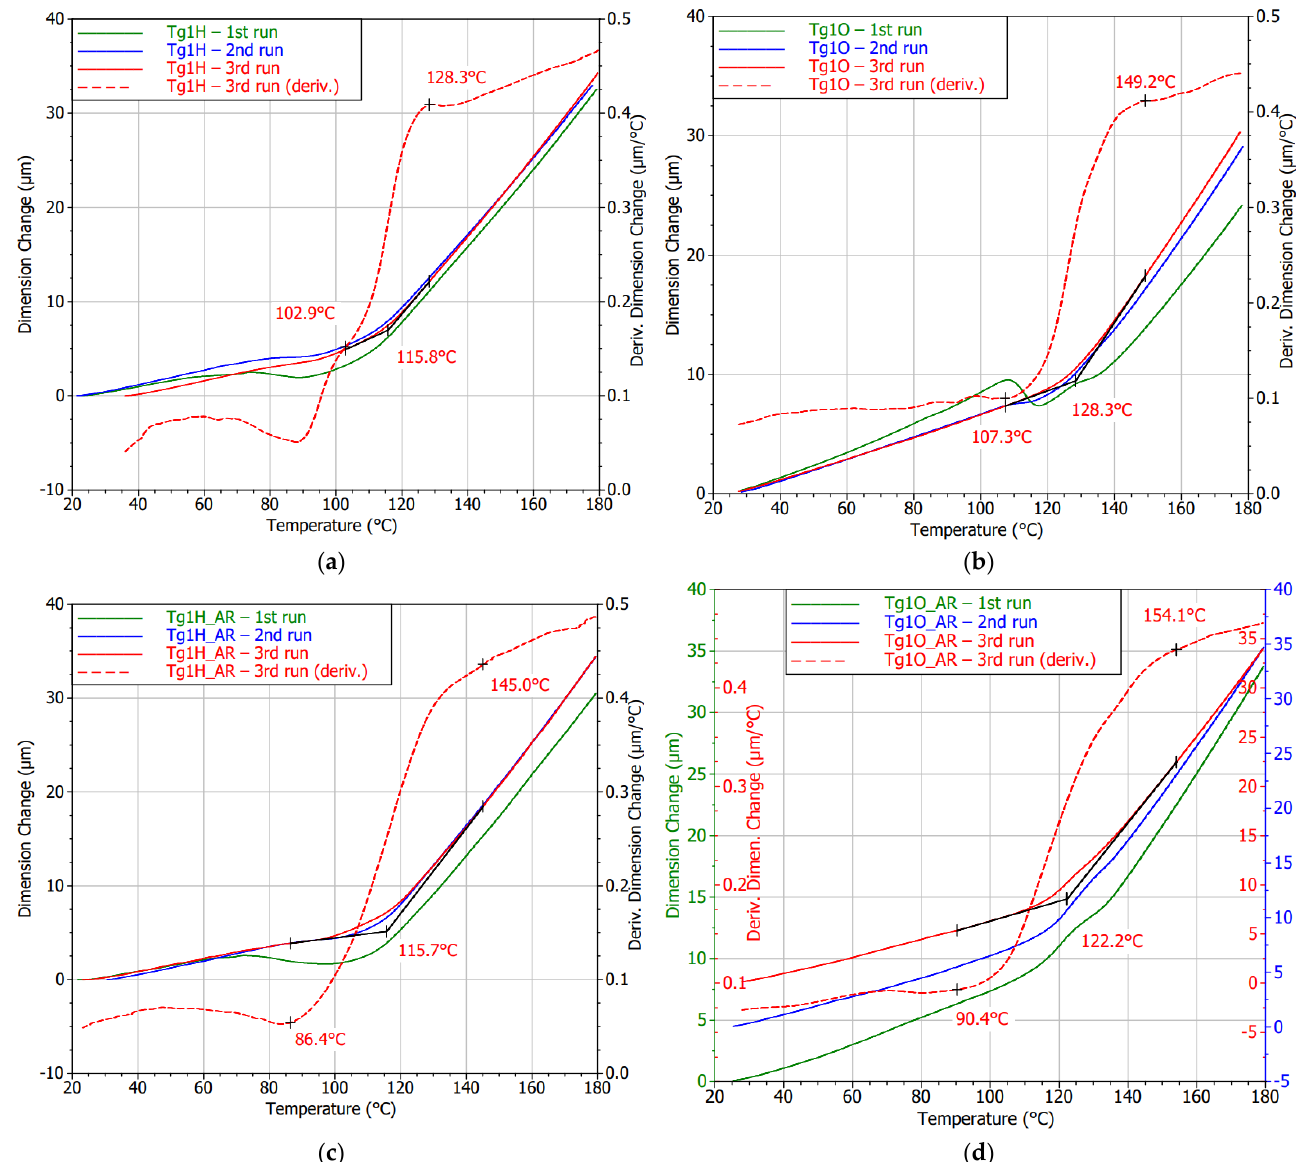
Figure 12. TMA diagrams of the Tg1 substrates and with surface finish: ( a ) HASL; ( b ) OSP; ( c ) HASL after reflow (AR); ( d ) OSP after reflow (AR). Table 4. Glass transition temperatures (expressed in Celsius) determined by TMA.